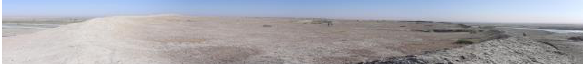
Figure 10 - View of the tell with entrance gate from